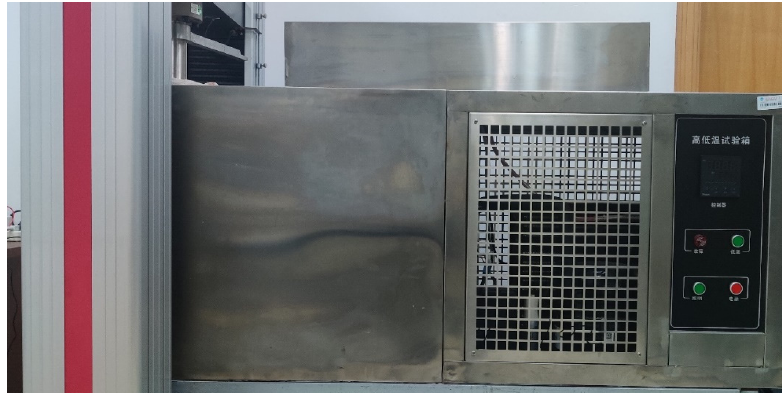
Figure 5. Low-temperature test chamber.